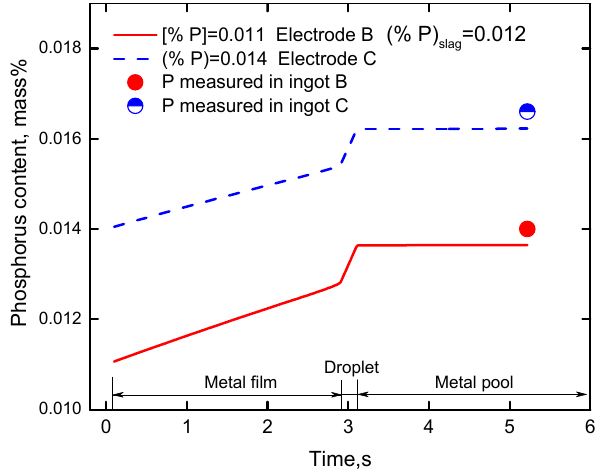
Figure 9. E ff ect of P content in electrode on P content in ingots with the same P content in slag.